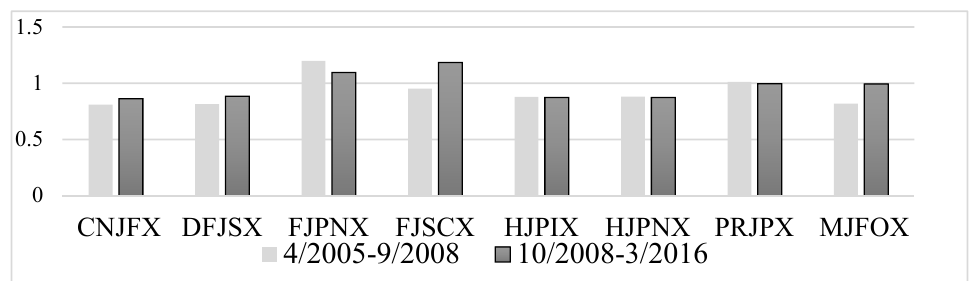
Figure 3 . Systematic risk (beta; in absolute terms) (benchmark: Mkt).